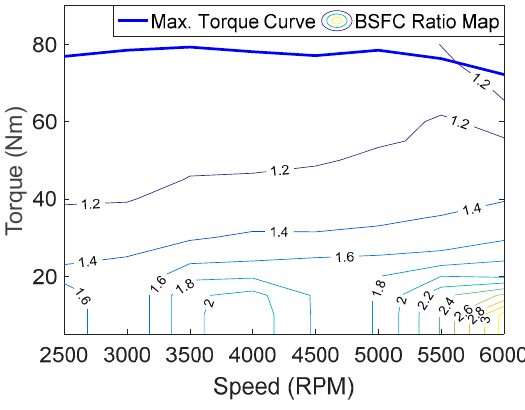
Figure 4. BSFC ratio map of the engine.